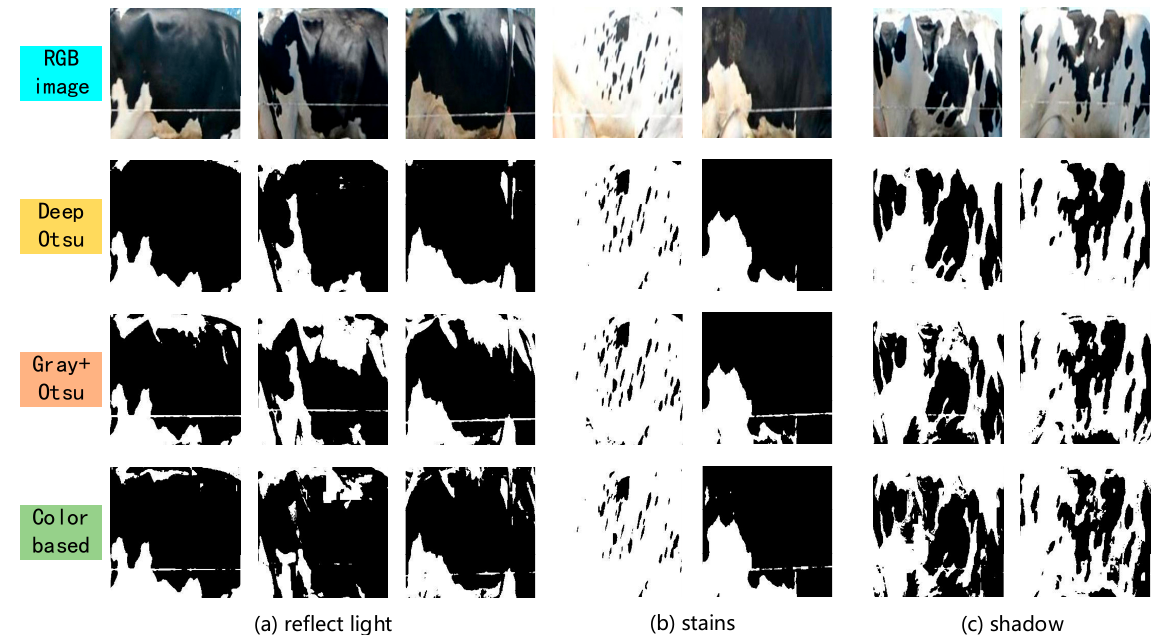
Figure 8. Comparison of three binarization methods under different conditions. In the figure, the images in the first row represent the RGB images to be binarized; the images in the second row represent the images binarized by the DeepOtsu model; the images in the third row represent the images after the grayscale conversion process and Otsu binarization; and the images in the fourth row represent images processed by color-based binarization. ( a ) reflect light ( b ) stains ( c )